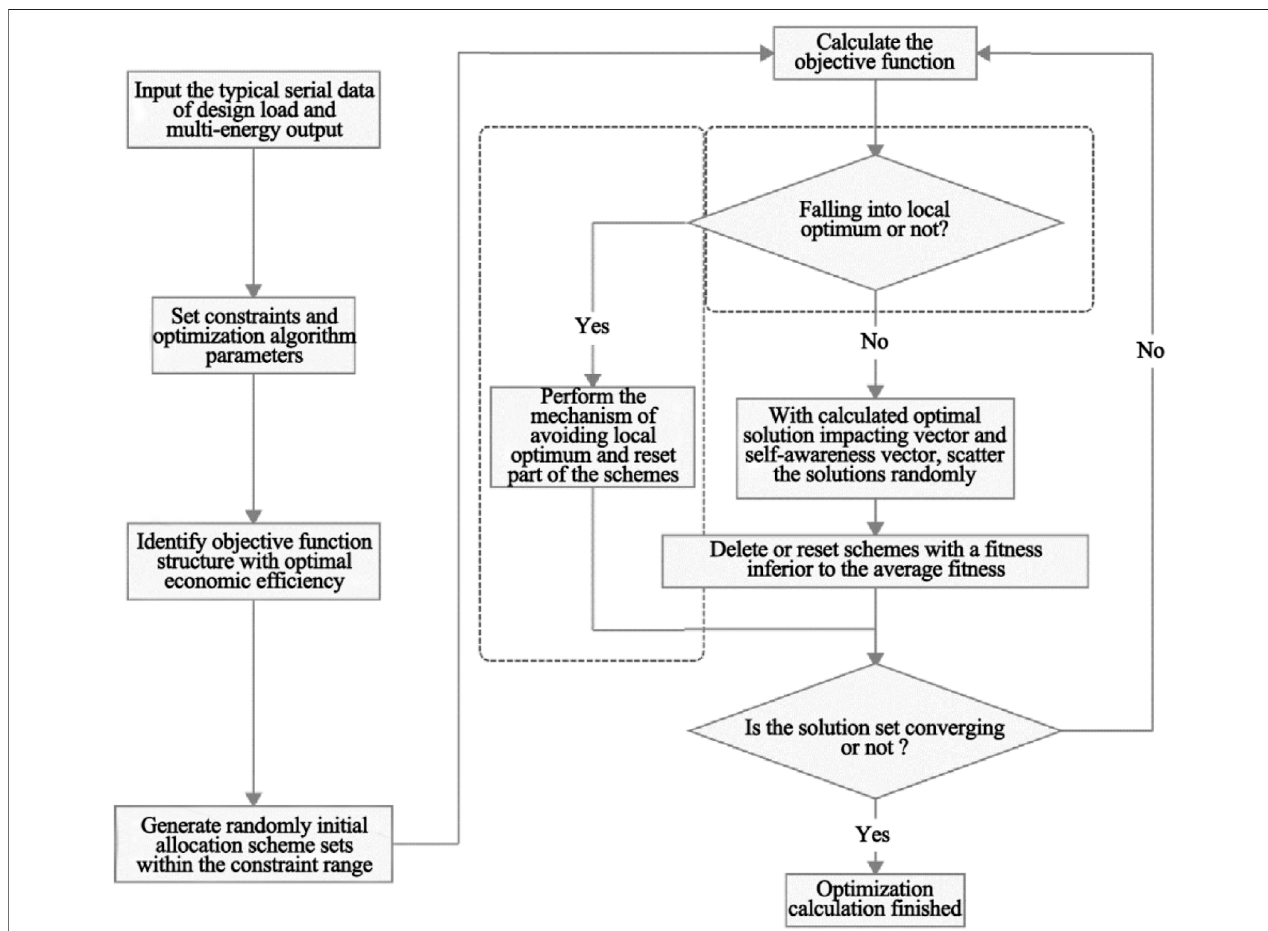
FIGURE 2 | Allocation optimization calculation process based on